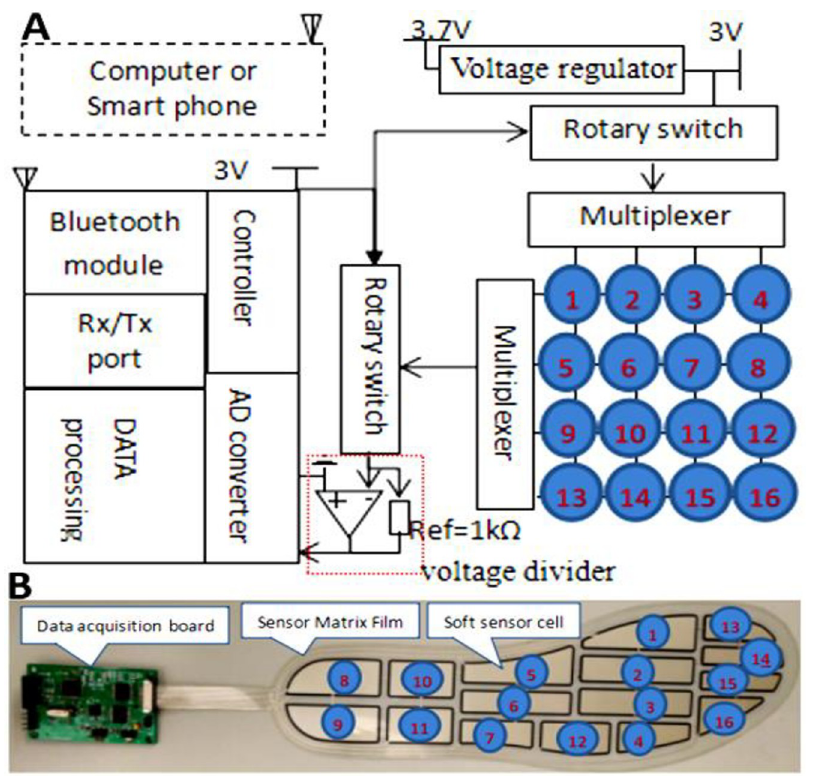
Fig 3. (A) Data acquisition model and (B) data acquisition module of DAQ